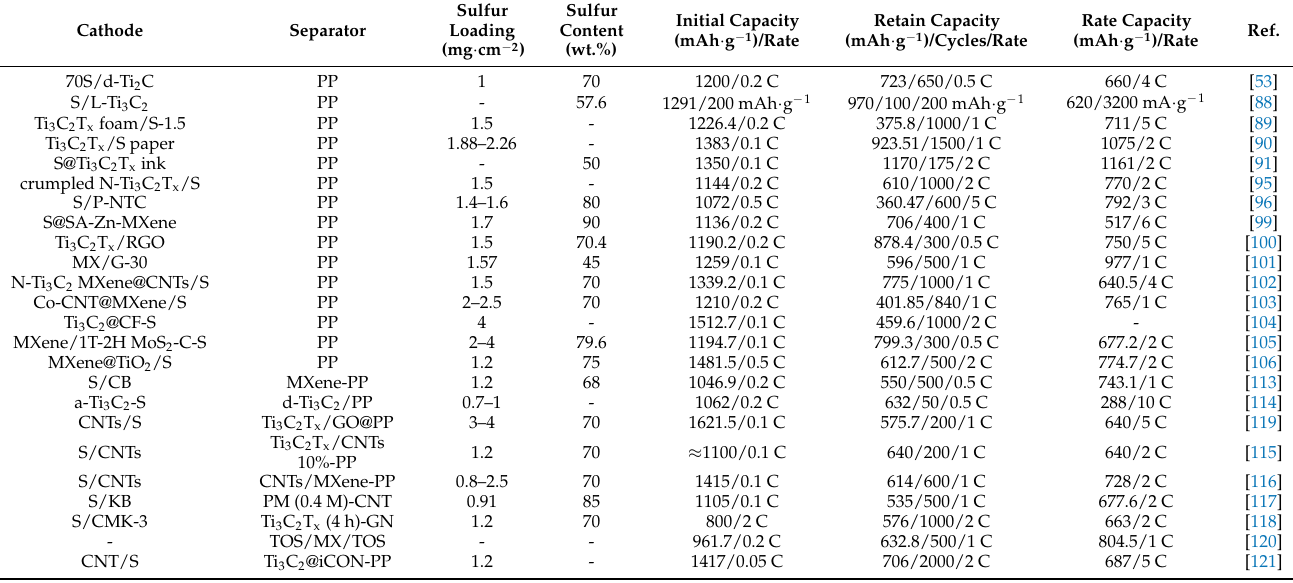
Table 1. Electrochemical performance of MXene-based cathodes and modified separators in